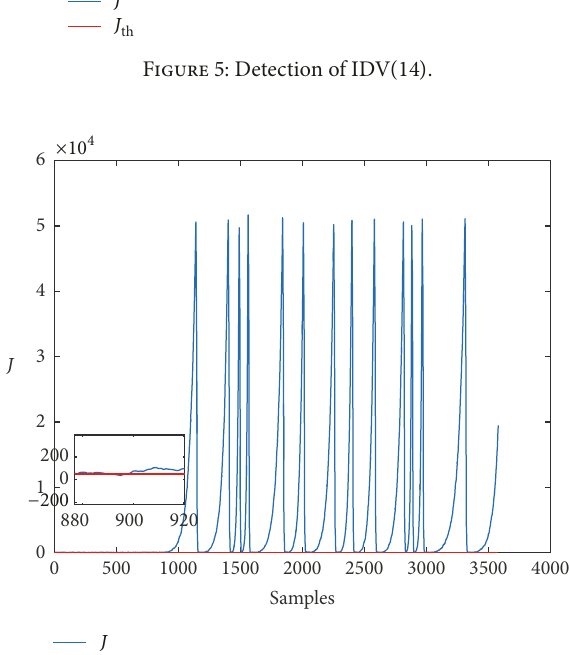
Figure 6: Detection of IDV (17)